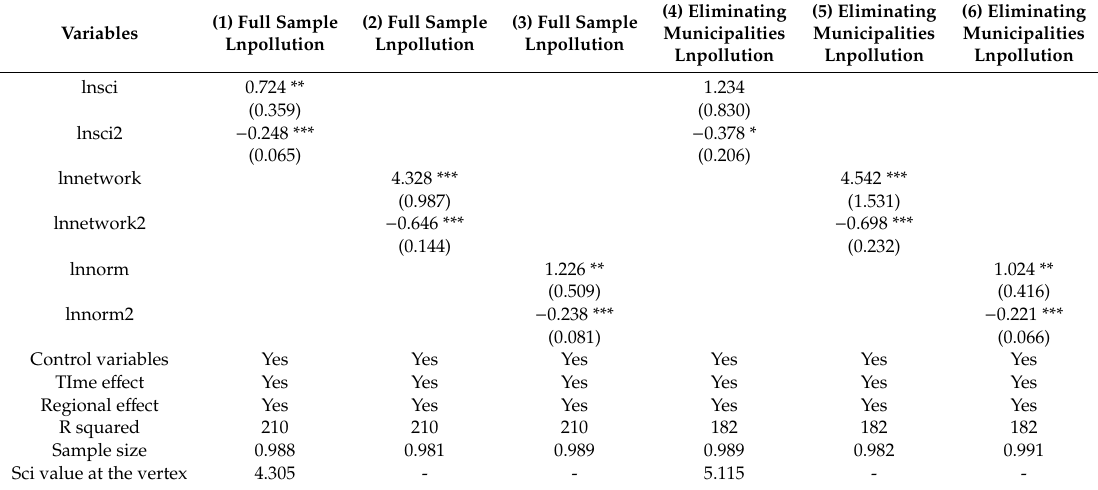
Table 7. Two-stage regression results of instrumental variable